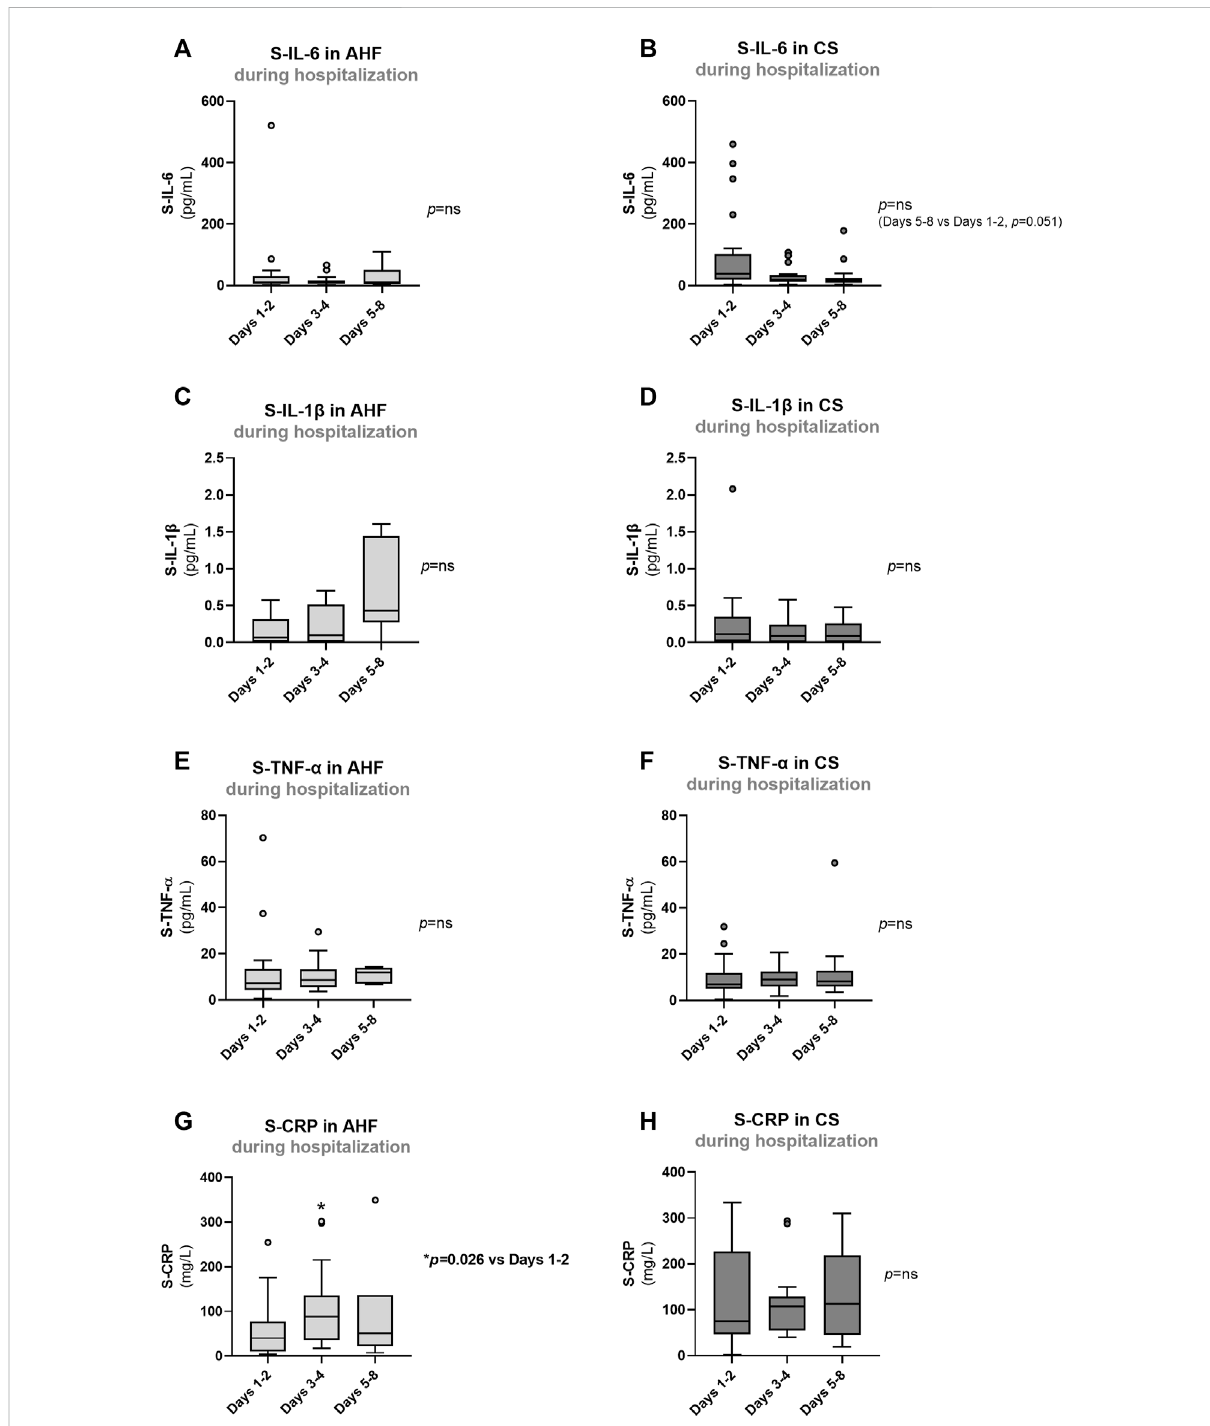
FIGURE 5 Evolution of biomarkers of in fl ammation in AHF and CS patients during hospitalization: (A,B) S-IL-6; (C,D) S-IL-1 β ; (E,F) S-TNF- α ; (G,H) S-CRP. Results are presented in Box-and-Whiskers plot. AHF, acute heart failure; CS, cardiogenic shock; S-CRP, serum C-reactive protein; S-IL-1 β , serum interleukin 1 β ; S-IL-6, serum interleukin 6; S-TNF- α , serum tumour necrosis factor